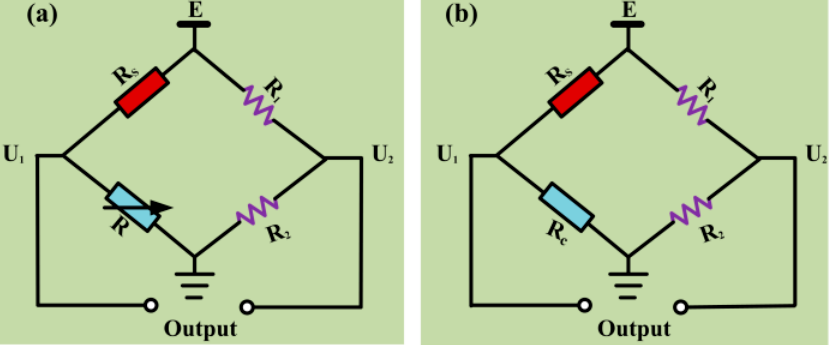
Figure 9. Direct current bridges: ( a ) for original signal testing, and ( b ) for steady signal testing with temperature compensation.